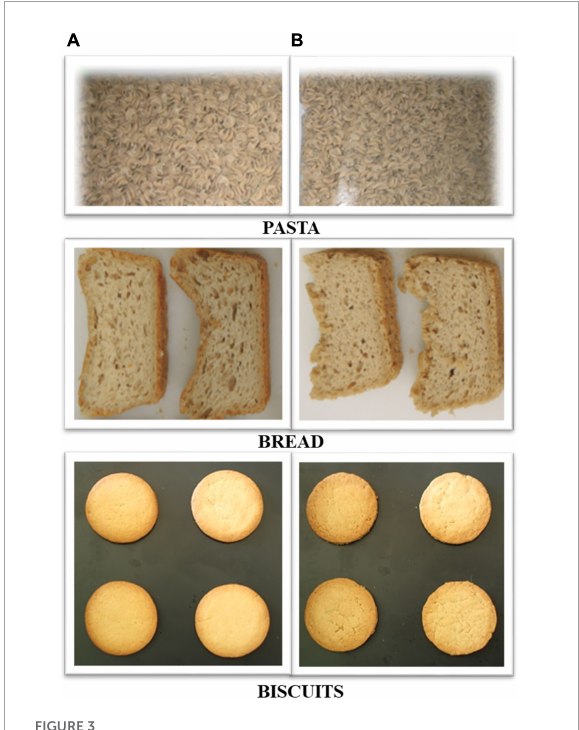
FIGURE3 Plant-based protein enriched products: (A) low protein-enriched (source of protein–SoP) product, (B) high protein-enriched (high in protein–HiP)